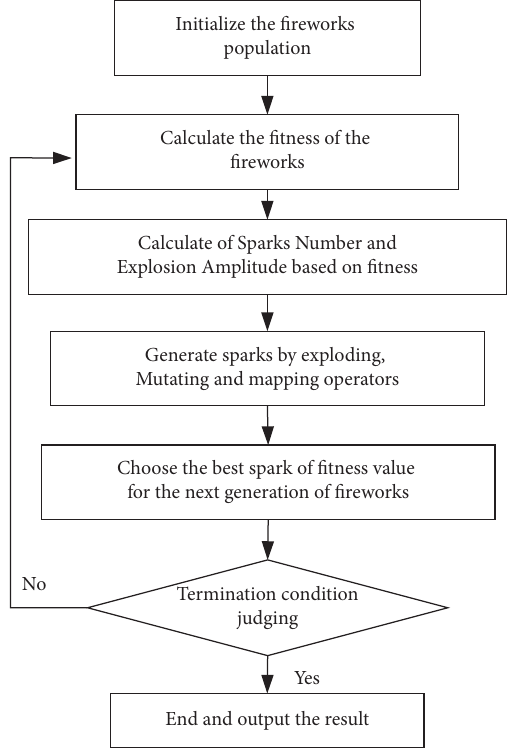
Figure 3: Process of FWA.